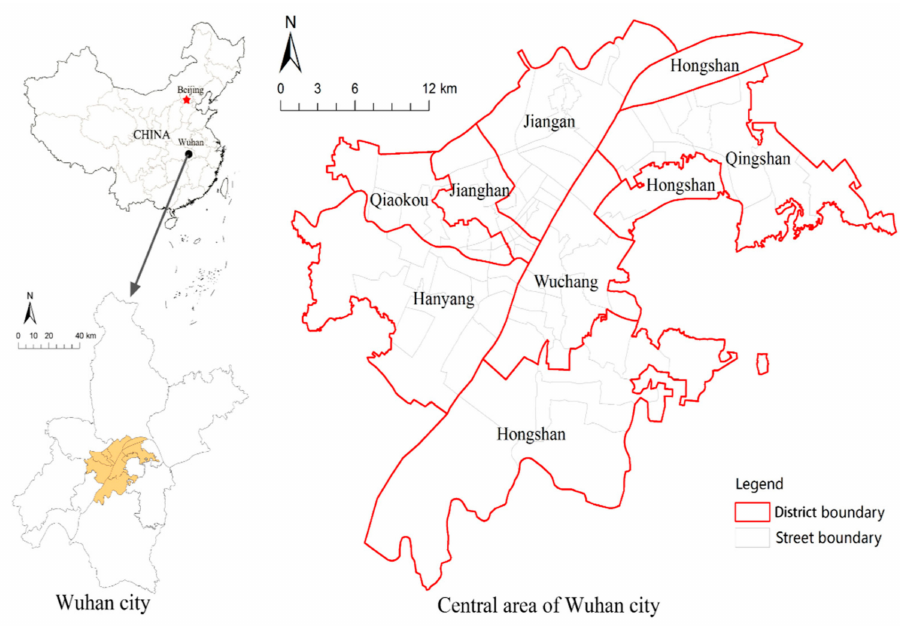
Figure 1. The location and administrative boundary of the study area.